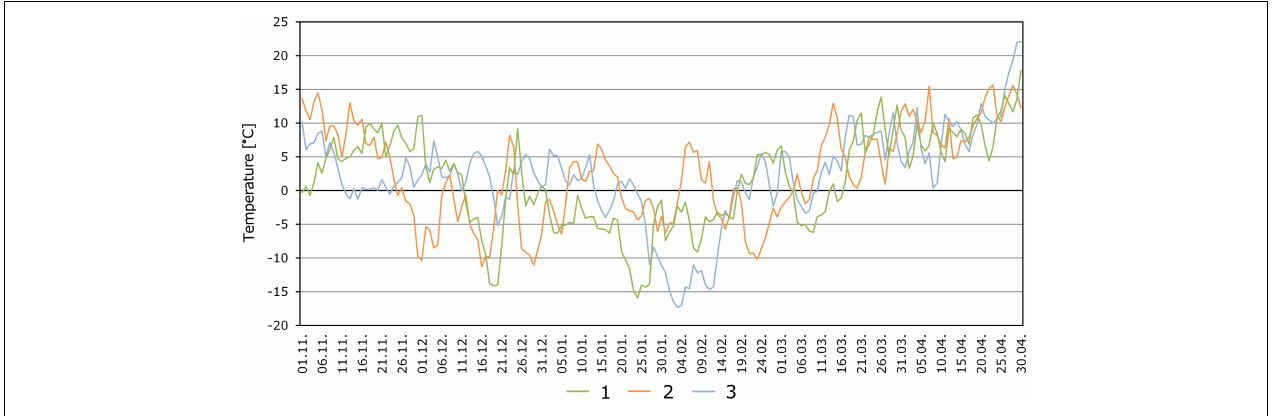
FIGURE 2 | Average air temperature values for the first (1), second (2), and third (3) winter seasons